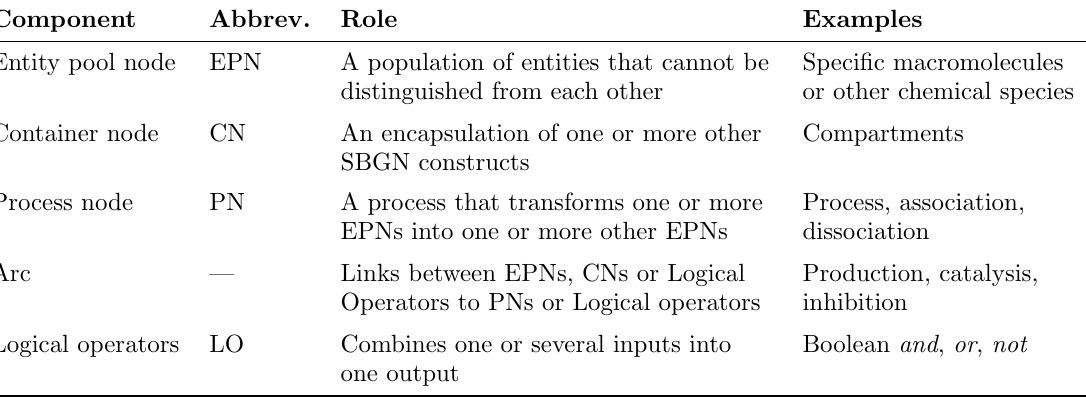
Table 2.1: Summary of Process Description components and their